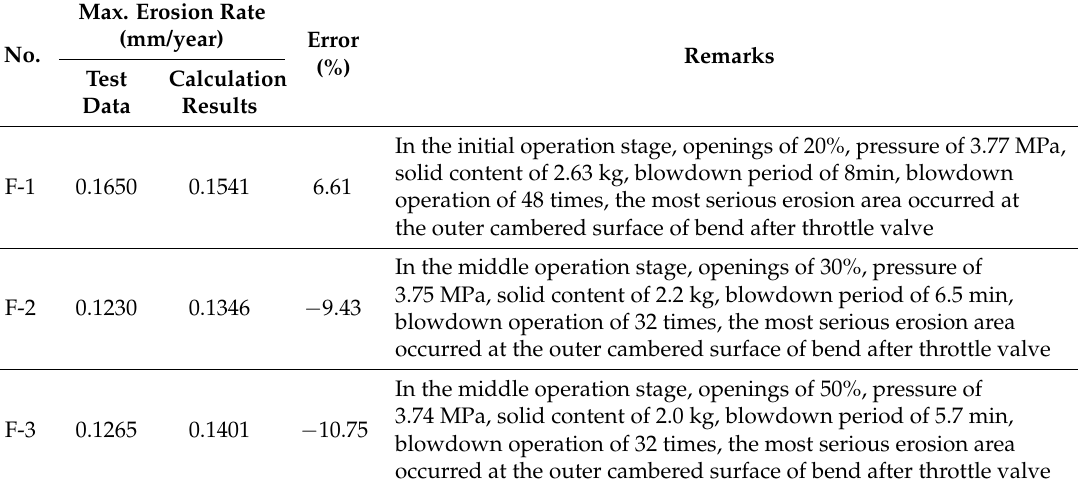
Table 2. Calculation results and test data